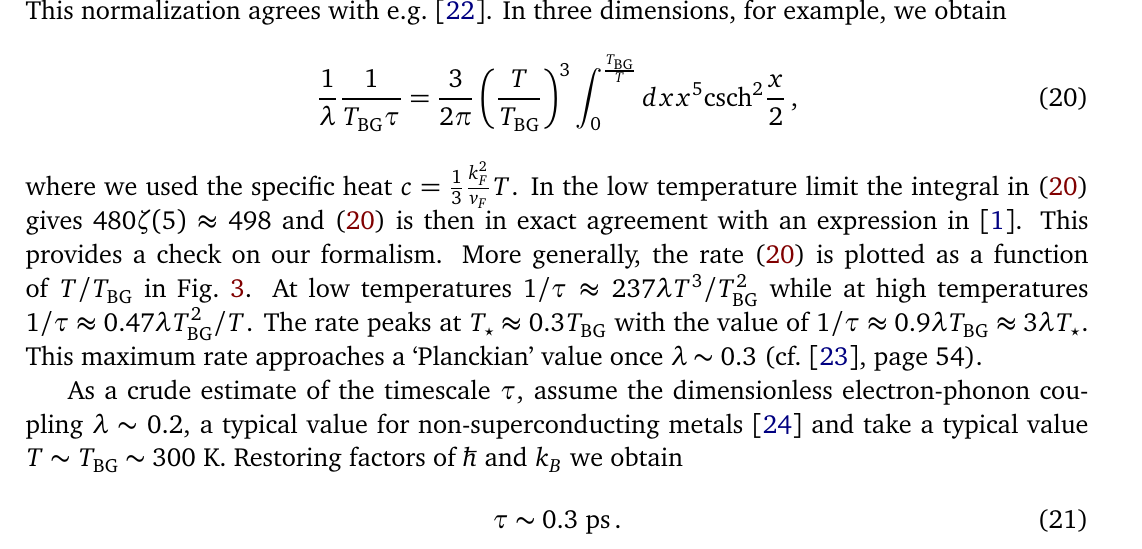
= 1 v . The constraint s F 20